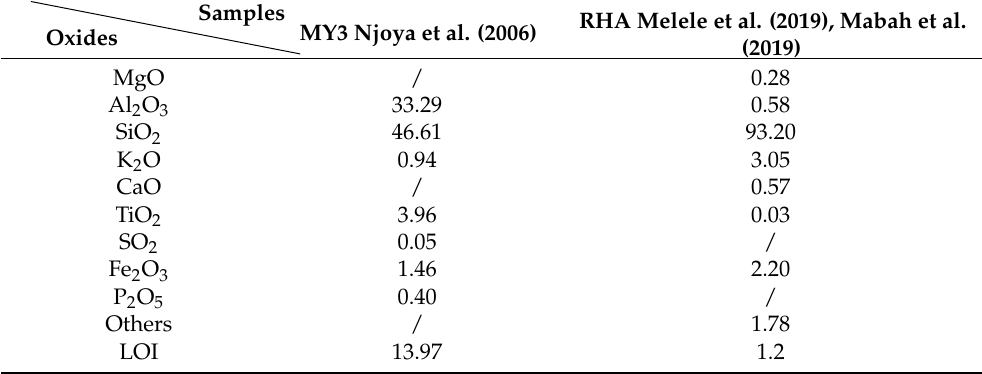
Table 3. Chemical compositions of kaolin (MY3) and rice husk ash (RHA), wt.%.